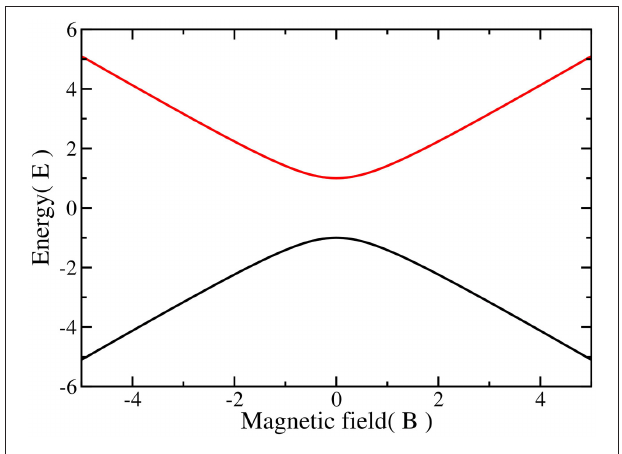
FIGURE 1 | The energy spectra of the Landau-Zener problem. There is a minimum energy gap when the excited state, in red, lies at its minimum energy difference with the ground state. This occurs at B z ( t ) = 0 .